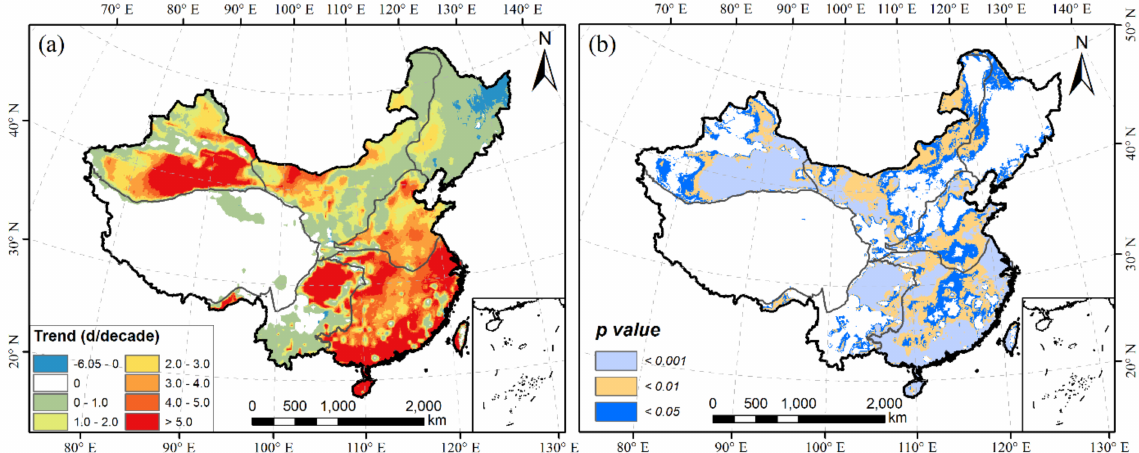
Figure 4. Changes of HTDs over China during the period 1979–2018. ( a ) Change trend; ( b ) corresponding statistical p values for HTDs, in which p < 0.001, p < 0.01, and p < 0.05 represents significant corresponding change trend at level of 0.001, 0.01, and 0.05,